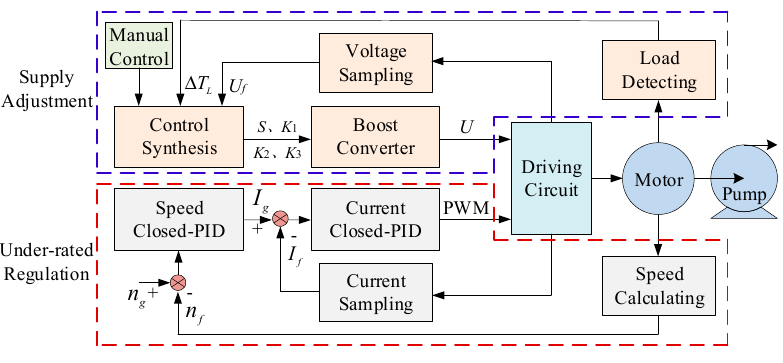
Figure 5. Control strategy block diagram.